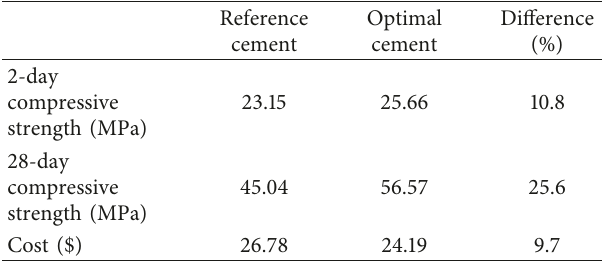
Table 7: A comparison of the reference cement and the optimal